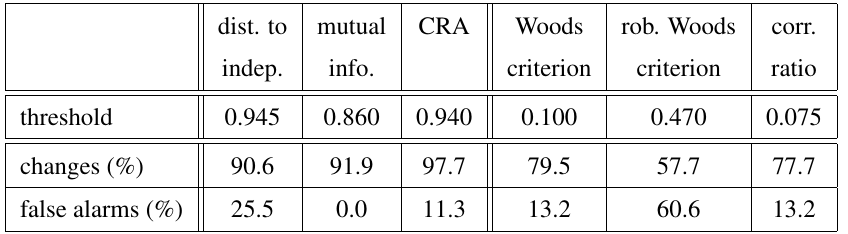
Table 6. Panchromatic/HS pair: change and false alarm estimates based on manually se- lected similarity measure thresholds.